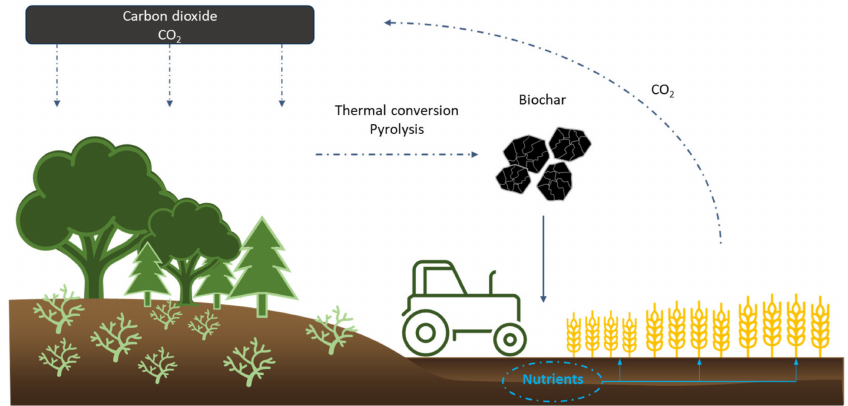
Figure 1. Utilization of biochar in CO 2 sequestration and soil